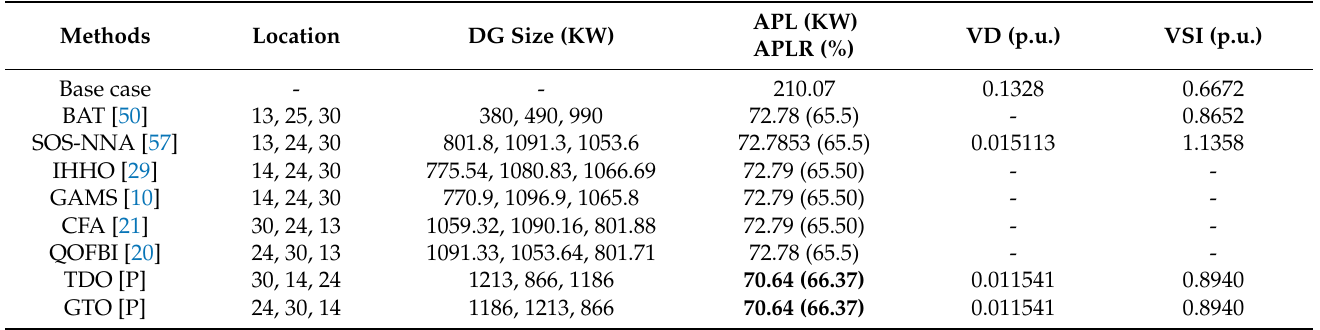
Table 4. Results comparison of the OADG for a 33-bus RDN for SOF (APL minimization) at unity pf (PV type) in a CP load model.